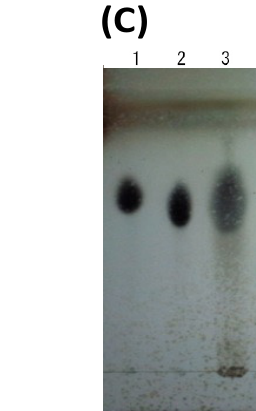
Figure 2. Analyses of the culture supernatant of C. cellulovorans with shredded paper. ( A ) SDS-PAGE and ( B ) Western blot analysis using an anti-CbpA antibody (1:2000 dilution). Lane M, molecular mass marker; lane 1, culture supernatant; lane 2, non-adsorption fraction against shredded paper; and lane 3, adsorption fraction against shredded paper. ( C ) TLC analysis. Lane 1, glucose (G1); lane 2, cellobiose (G2); and lane 3, culture supernatant.